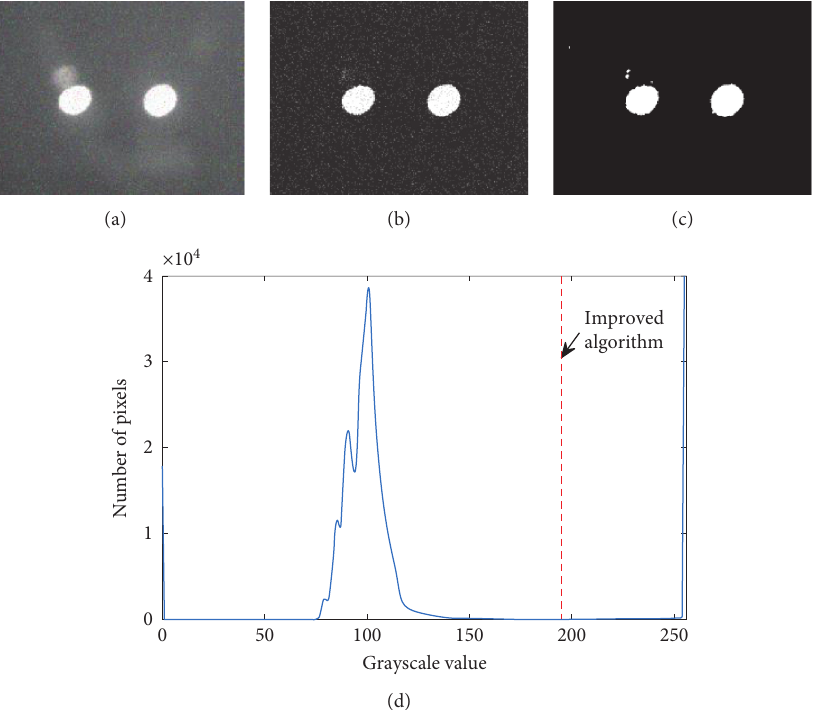
Figure 13: The effect of ghost imaging interference laser speckle segmentation under impulse noise: (a) original image, (b) improved algorithm, (c) morphological processing, and (d) histogram and each segmentation threshold.